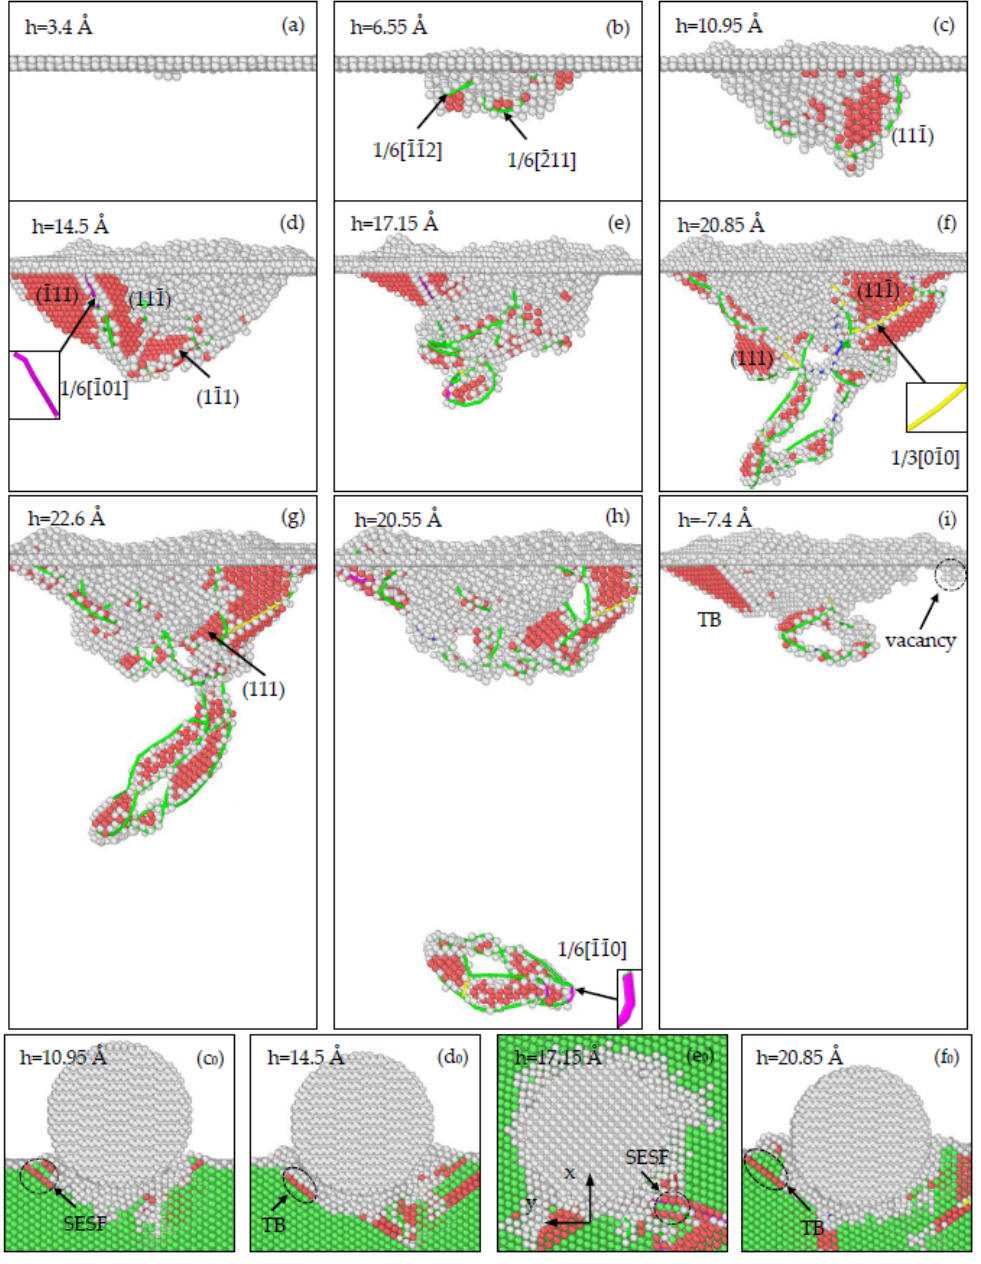
Figure 5. Defect evolution in the (110) sample during the loading process ( a – g , c 0 – f 0 ), and the unloading process ( h – i ). (SESF is the external stacking fault, TB is the twinning boundary).